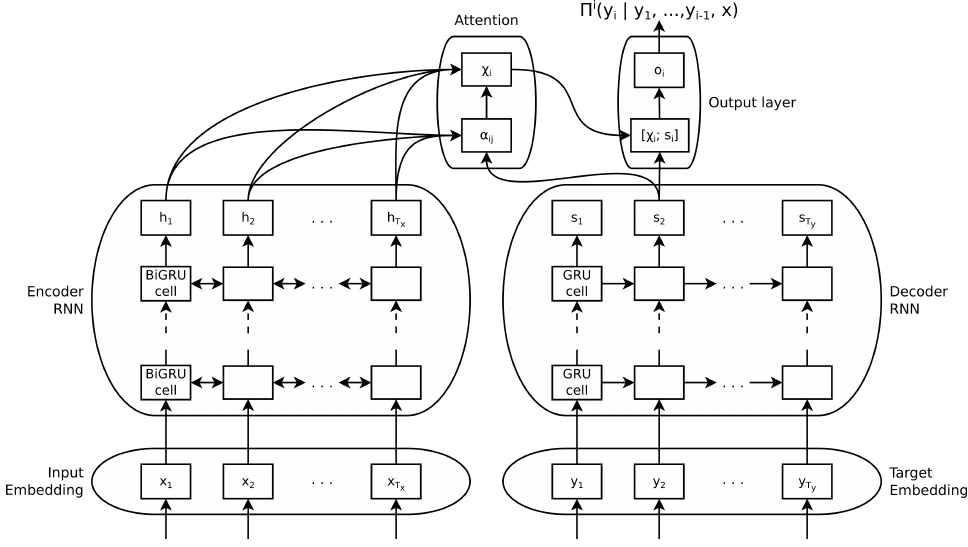
Figure 1. Encoder–decoder with attention